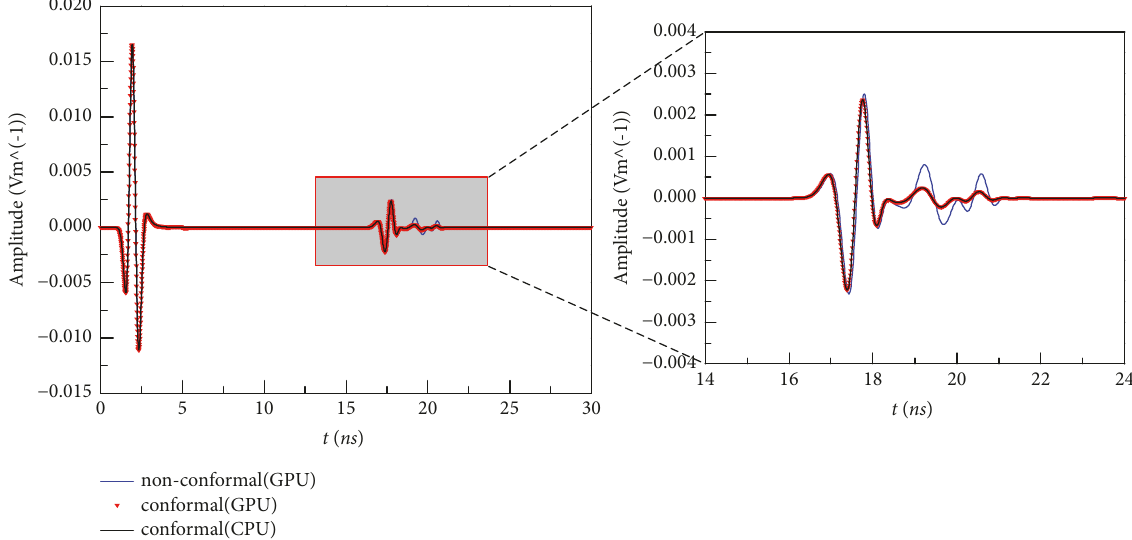
Figure 10: A map of the single-track radar data for the embankment model calculated using three